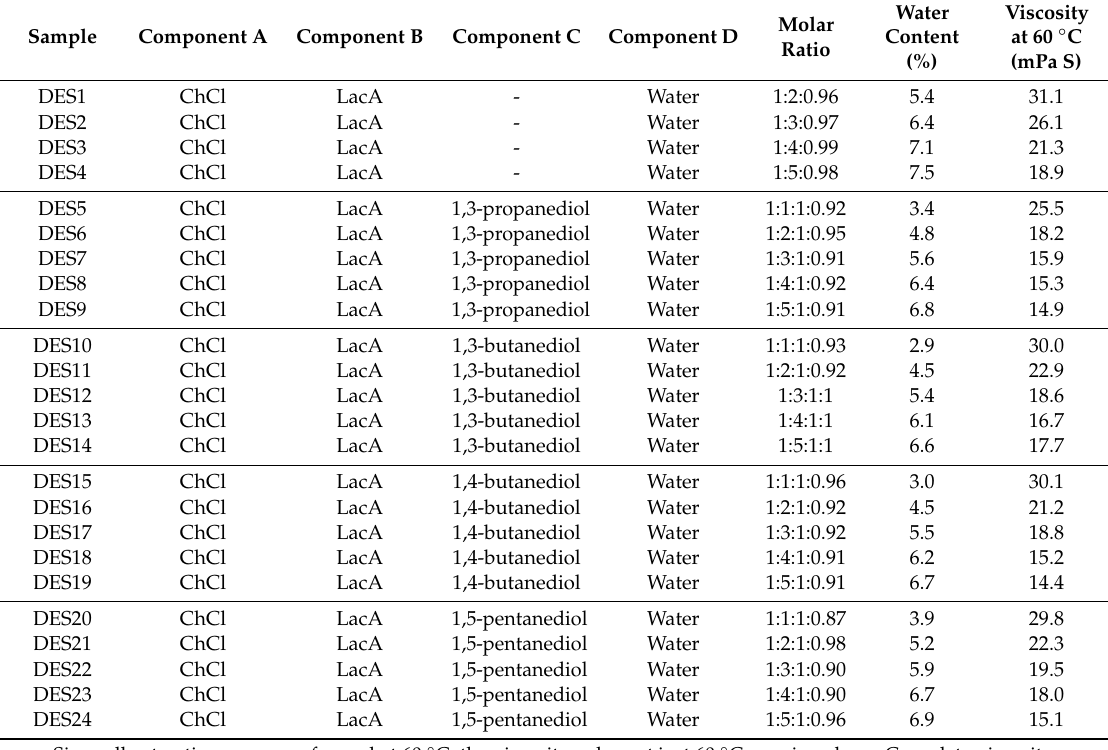
Table 2. Prepared deep eutectic solvents (DESs), molar ratios of their components, and viscosity. Sample